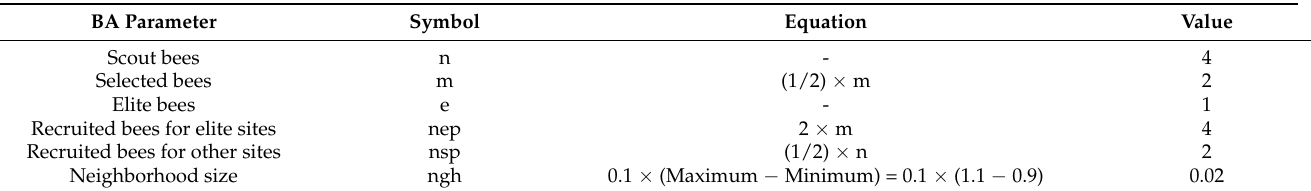
Table 2. The values of BA